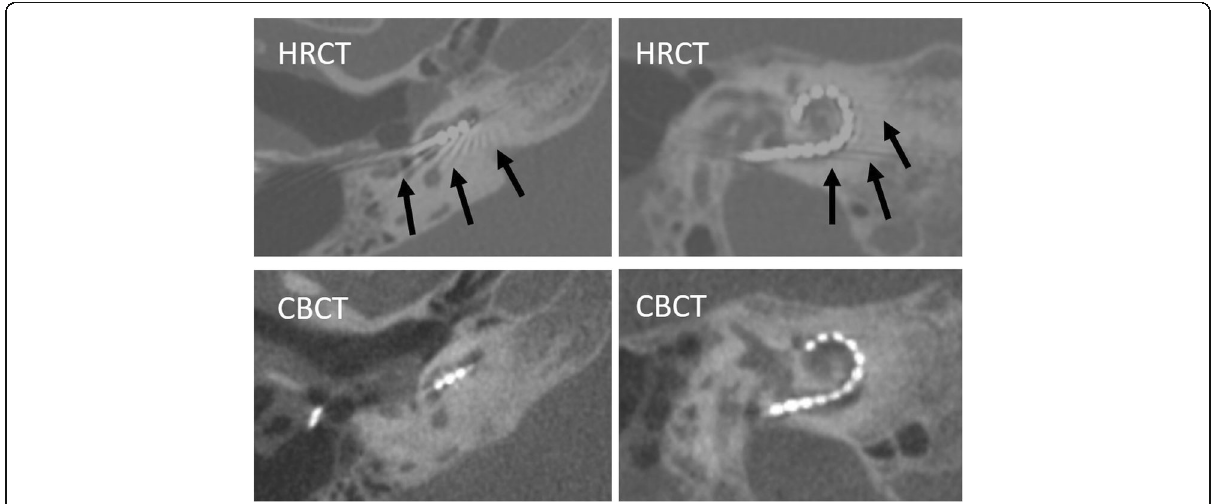
Fig. 18 Comparison of postoperative HRCT and CBCT in a 53-year-old female patient. Axial (left images) and paracoronal (right images) images. HRCT images show more metal artifacts (arrows) and blooming artifacts than CBCT images. However, the scalar location and number of